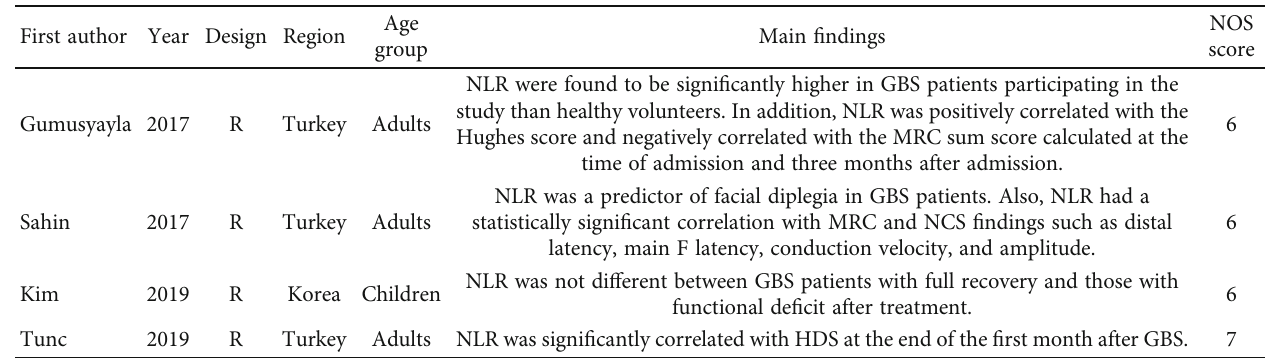
Table 2: General characteristics of studies included merely in qualitative review.